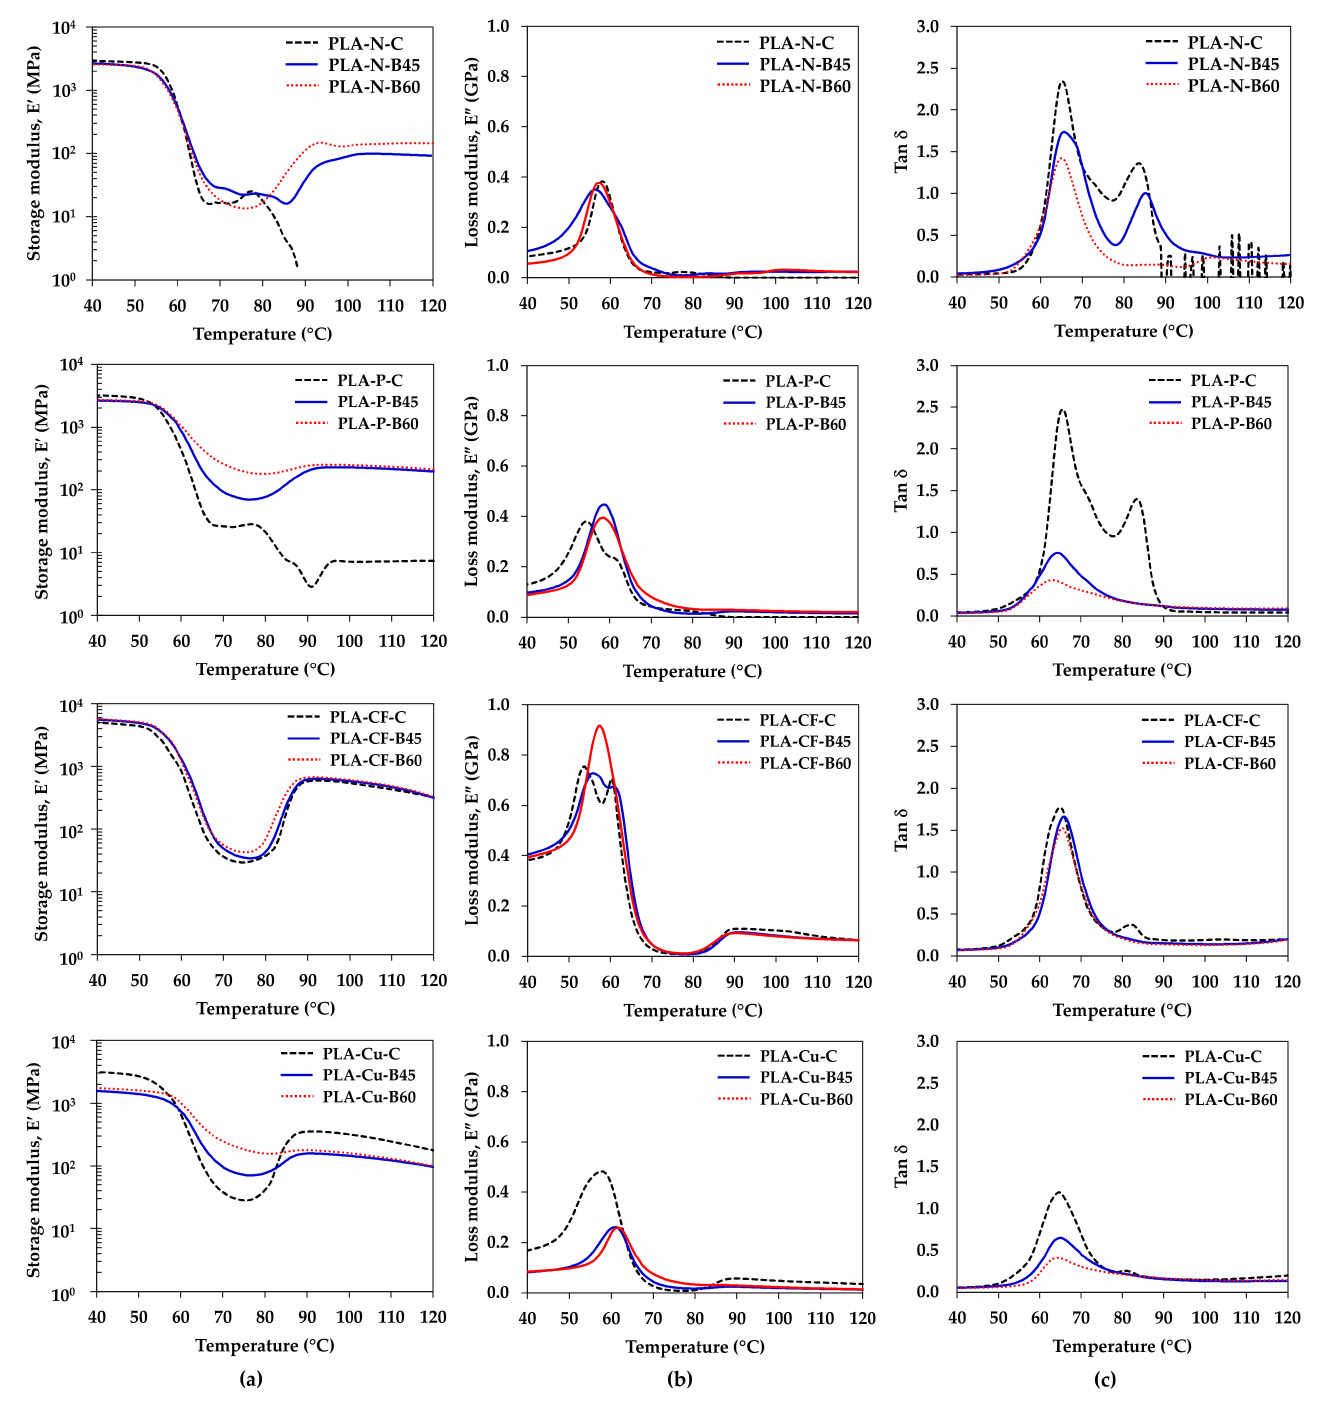
Figure 8. Storage modulus, loss modulus and Tan δ of compression molded sheets and 3D printed samples: ( a ) Storage modulus; ( b ) Loss modulus; and ( c ) Tan δ